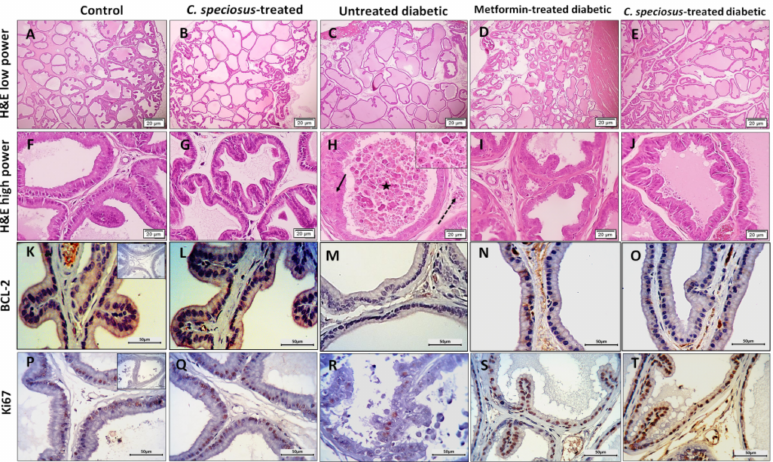
Figure 4. Sections of ventral prostates of control and C. speciosus- treated rats show intact prostatic acini with different sizes and shapes and with many epithelial folds while those of untreated diabetic rats show enlarged, widely separated acini with reduced height of acinar epithelium, less epithelial folds and many degenerated epithelial cells (arrow) that appear in the lumen (star) as well as dilated capliraries (interrupted arrow). Ventral prostate of metformin- and C. speciosus -treated diabetic rats show much preserved structure (Haematoxylin and eosin stained sections ( A – J ). Ki67 and BCL-2 immunoexpression in ventral prostate are shown ( K – T ). Inserts of the control group show the negative control of the